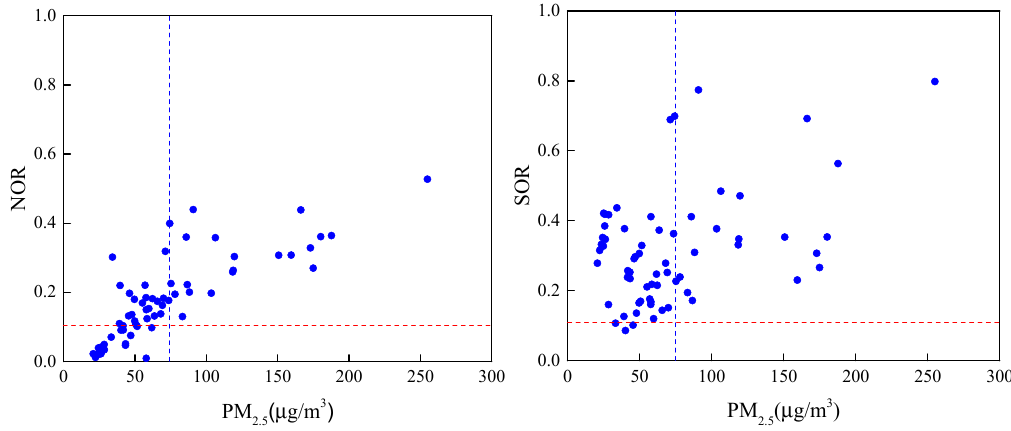
Figure 5. The values of the nitrogen oxidation rate (NOR) and sulfur oxidation rate (SOR) in different PM 2.5 concentrations. The horizontal dash line represents 0.1. The vertical dash line represents PM 2.5 = 75 µg/m 3 .